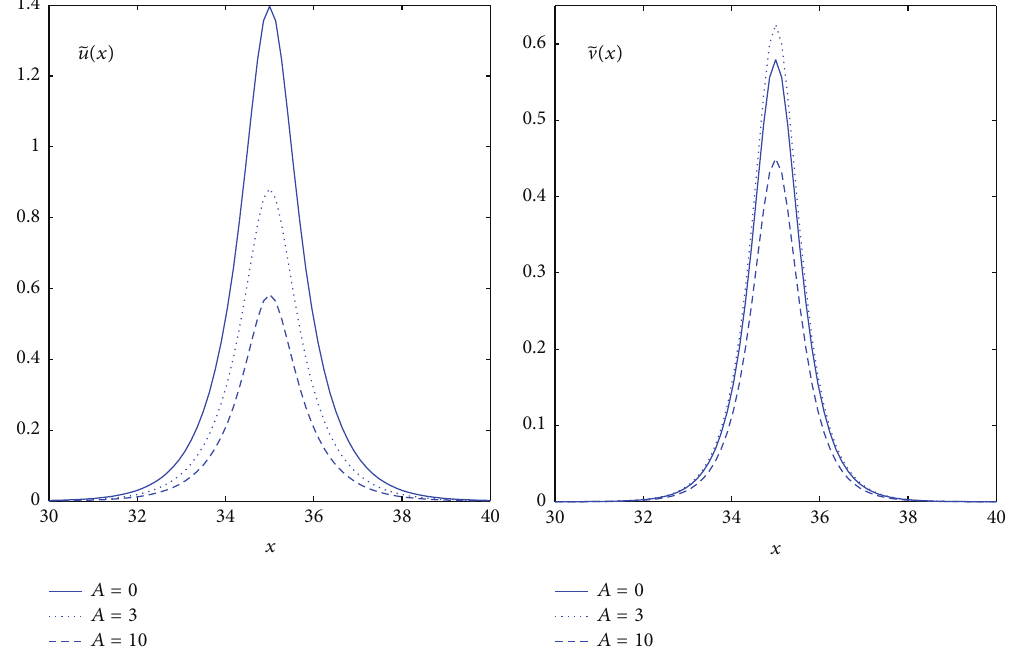
) , 𝑏(𝑥) = 𝑑(𝑥) = 2 sech 𝑝 (𝑥 − 𝑥 0